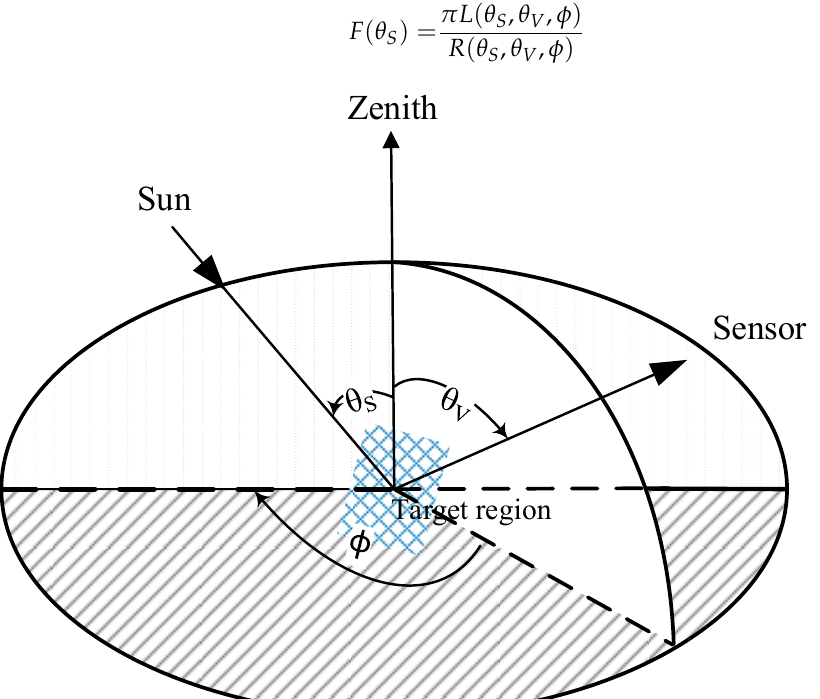
Figure 5. Diagram of Earth showing the sensor, Sun, and target geometry. According to [35], R is obtained from a set of predetermined empirical ADMs defined for several scene types with distinct anisotropic characteristics. Each ADM is constructed from a large ensemble of radiance measurements that are sorted into discrete angular bins and parameters that define an ADM scene type. The ADM anisotropic factors for a given scene type ( j ) are given